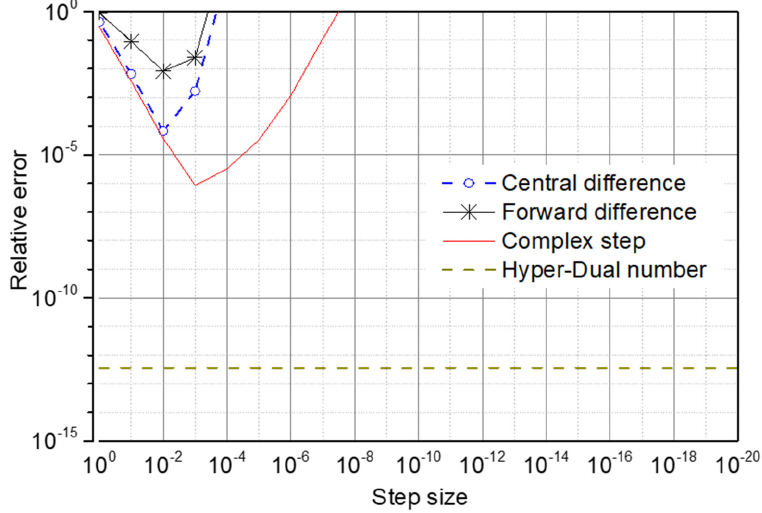
Figure 8. The third derivative of the nonlinear stiffness matrix ∂ 3 K / ∂ q 1 ∂ q 2 ∂ q 3 —errors of numerical methods.